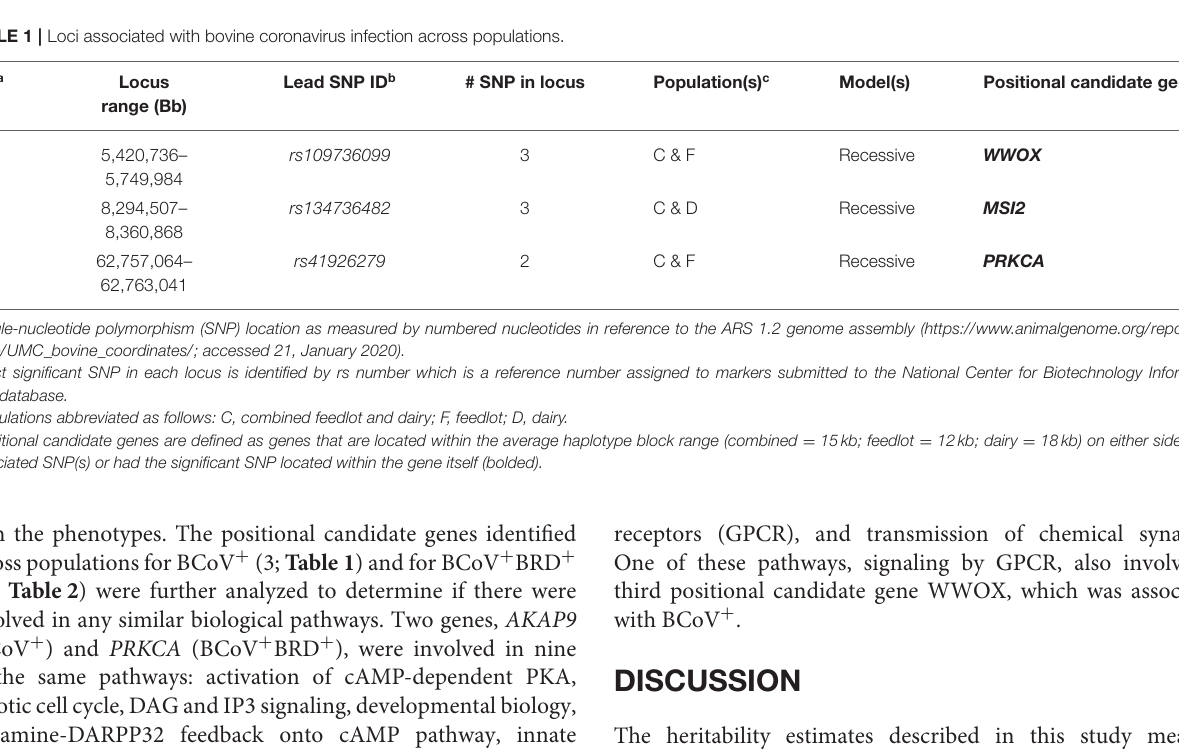
FIGURE 3 | Manhattan plots identifying loci associated with bovine coronavirus infection in additive (A) , dominant (B) , and recessive (C) EMMAX models for the combined dairy and feedlot population. Single-nucleotide polymorphisms (SNP) are represented by a single dot. Bovine chromosomes are listed on the x-axis. SNPs located between the black and red lines provide evidence of a moderate association ( p between 1 × 10 − 5 and 5 × 10 − 07 ), and SNPs above the red line provide evidence of a strong association ( p < 5 × 10 − 7 ) based on the Wellcome Trust Case Control Consortium ( 24) guidelines.